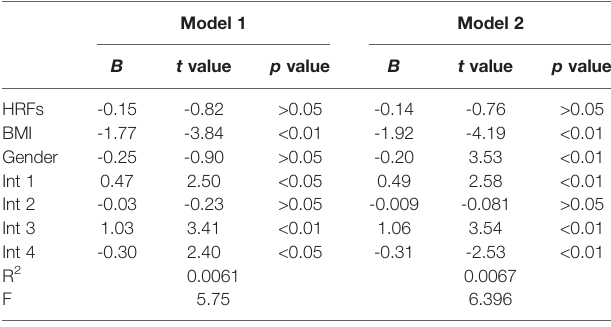
Model 1: crude model, model 2: the model was controlled for waist circumference, hip circumference. Independent variables: HRFs, dependent variables: